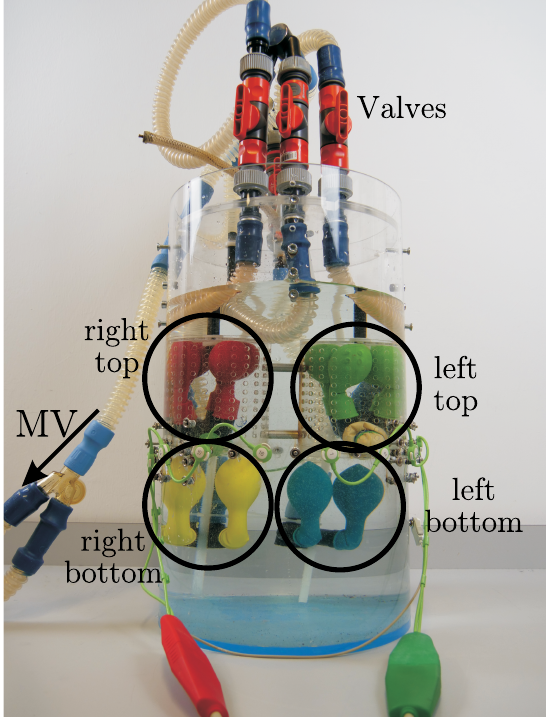
Fig.4: Water tank phantom used for experimental validation. Four lung lobes are represented by balloons. All lungs can be opened and closed separately by an individual valve. The ventilation is realized by a mechanical ventilator (MV). The fourth valve is not visible as it is behind the other valves. In this image, the measurement setup for the EIT reference measurement using a single electrode belt is